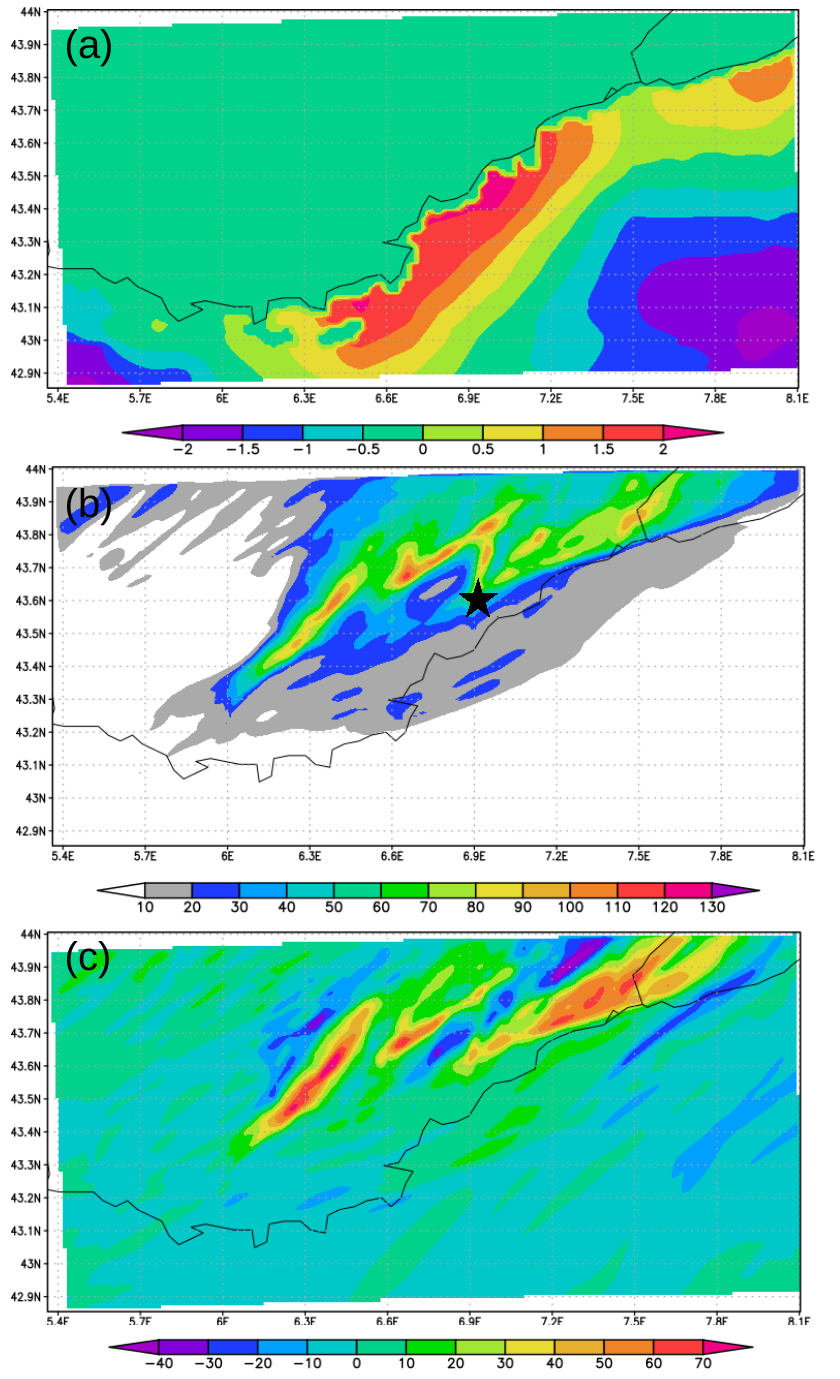
Figure 8. Panel ( a ): Sea surface temperature (SST) difference ( ◦ C) between satellite-derived and GFS analyses at 00 UTC, 3 October 2015. Panel ( b ): 6 h simulated precipitation (mm) provided by W_GFS_SST simulation. Panel ( c ): 6 h cumulated precipitation difference (mm) between W_GFS and W_GFS_SST simulations. Accumulation period is 17 UTC–23 UTC, 3 October 2015. Black star identifies observed precipitation peak